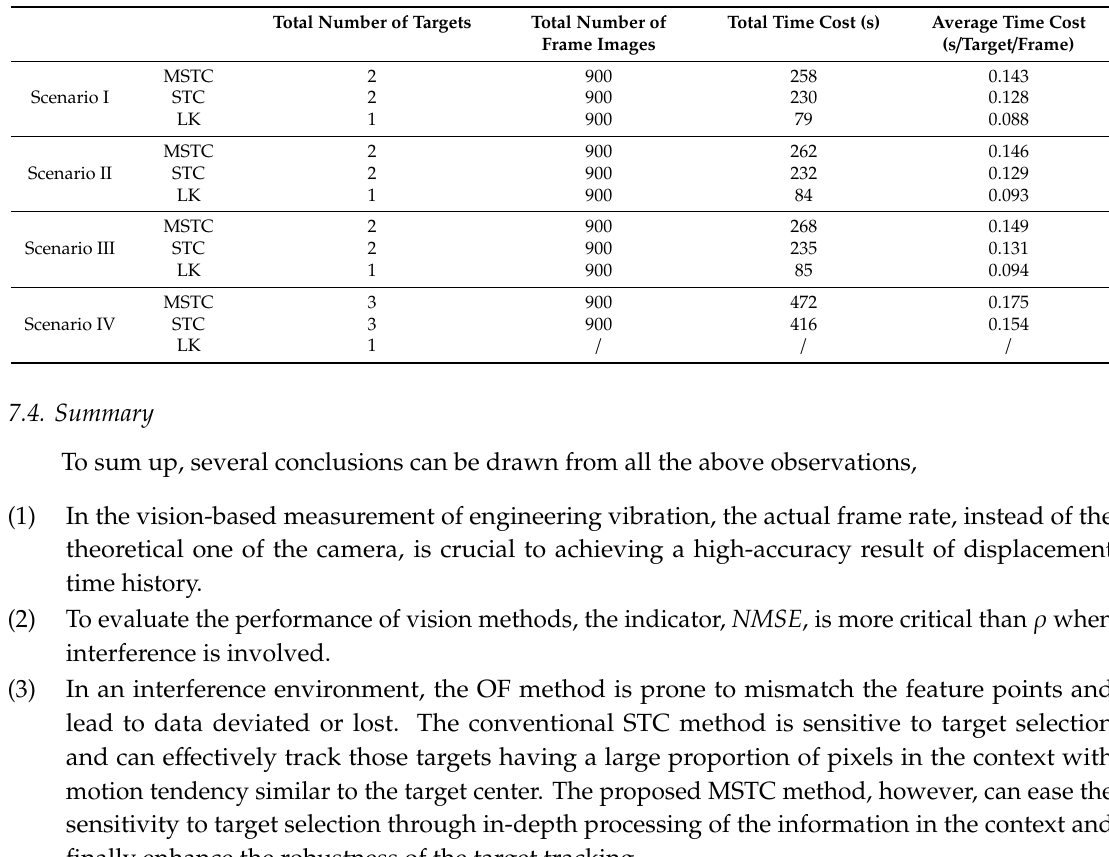
Table 7. Time consumption for displacement